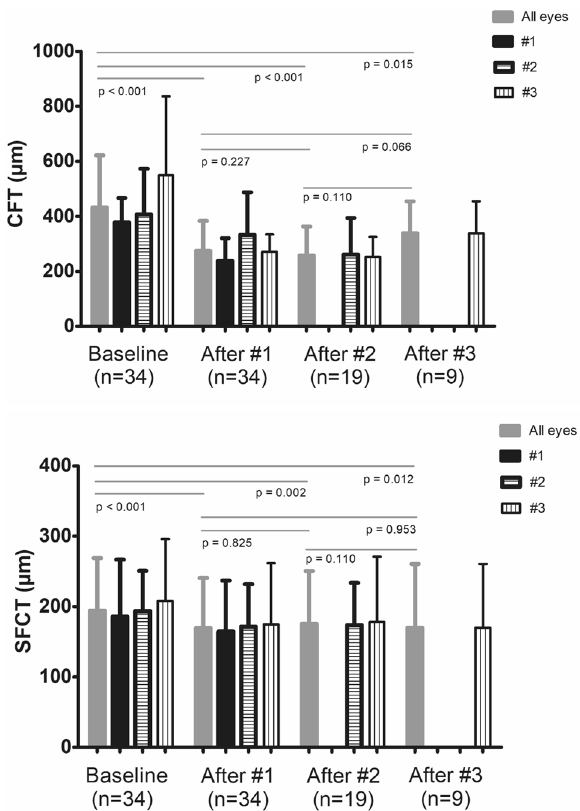
Figure 1. Change of central foveal thickness (CFT) and subfoveal choroidal thickness (SFCT) after intravitreal brolucizumab treatment stratified by number of injections. Data were presented with mean and standard deviation. Eyes were divided into three groups according to the number of brolucizumab injections. CFT and SFCT were significantly decreased after brolucizumab injection compared to the baseline in all three groups ( P < 0.05). P value was obtained from paired T test or Wilcoxon signed rank